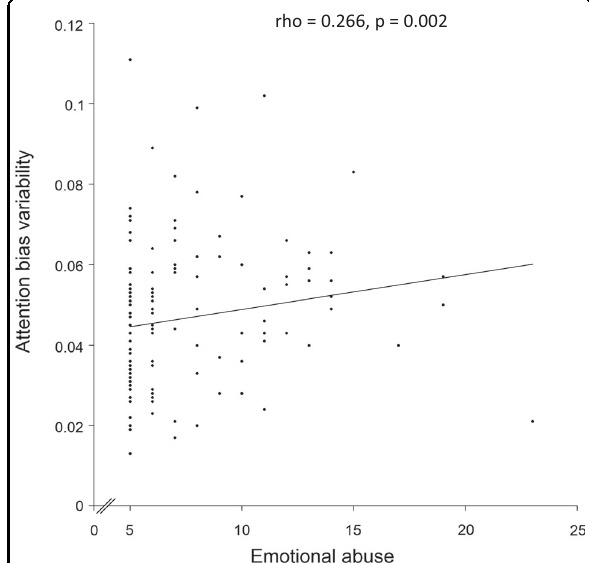
Fig. 1 Scatterplot showing the relationship between childhood emotional abuse and attention bias variability. History of childhood emotional abuse was signi fi cantly positively correlated with attention bias variability (rho = 0.266, P = 0.002).